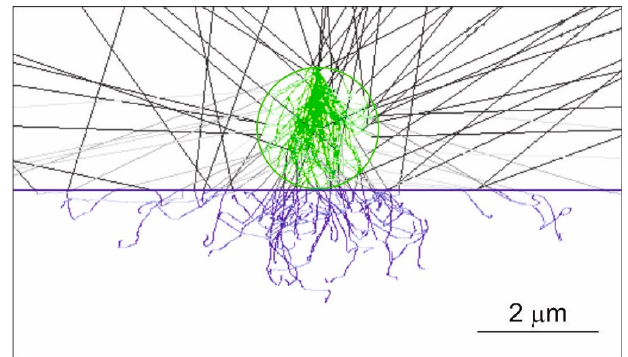
Figure 7. Middle section of the simulated electron trajectories in an Egyptian blue fragment of spherical shape (2.0 µm diameter) with an electron beam energy 20 keV. The trajectories of electrons in interaction with the sample (green), with the carbon substrate (blue) and the backscattered electrons (black) are clearly seen. The electron probe (size of 5 nm, zero divergence) is focused on the topmost point of the spherical pigment particle.